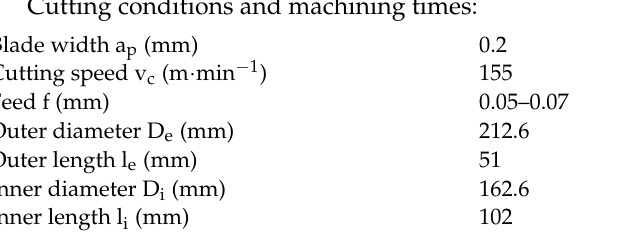
Table 2. Roughing time t h